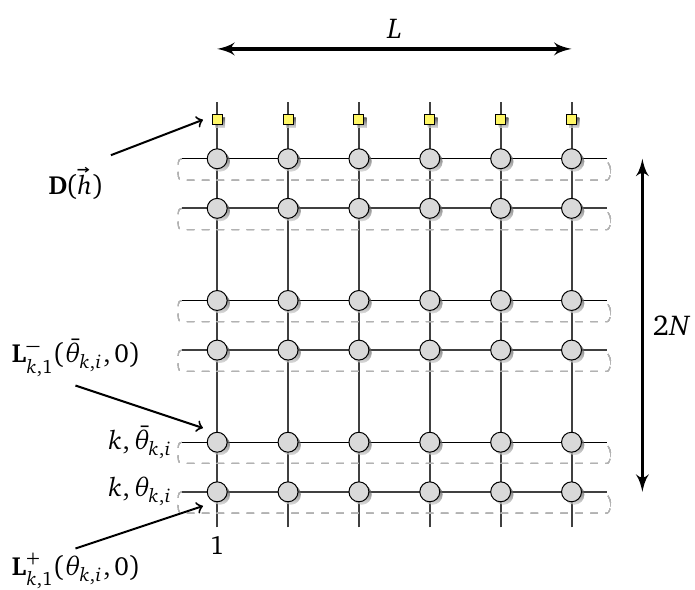
Figure 2: An illustration of the integrable two-dimensional vertex model correspond- ing to a regularised equilibrium macrostate, defined on a cylinder of circumference L and height 2 N . The ‘Boltzmann weights’ are given by the matrix elements of the Lax matrices attached at each vertex. The square vertices attached at the vertical bound- (cid:126) h -dependent twist, and the dashed gray lines denote traces over ary incorporate the the auxiliary